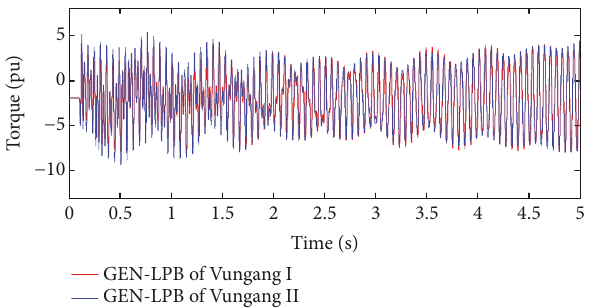
Figure 10: The speed deviation in GEN, LPB, LPA, and HIP shaft sections of Vungang I plant’s unit 1 during and after clearing